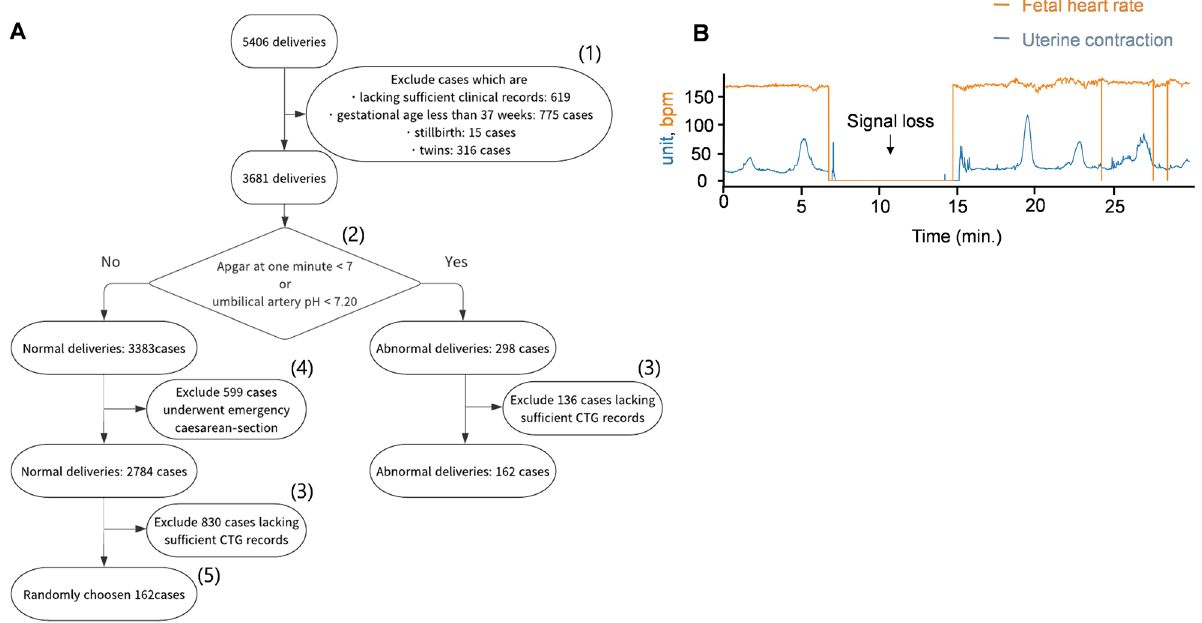
Figure 1. ( A ) Flowchart of data sorting. (1) Twins, stillbirths and premature deliveries were excluded. (2) The remaining 3681 data were classified into the normal and abnormal groups by Apgar score at 1 min and umbilical artery pH. (3) Deliveries lacking sufficient CTG records were excluded for both groups. (4) Normal cases that underwent emergency cesarean section were excluded. (5) A total of 162 (same as the number of abnormal cases) normal cases were randomly subsampled. ( B ) Representative figure of signal loss in FHR and